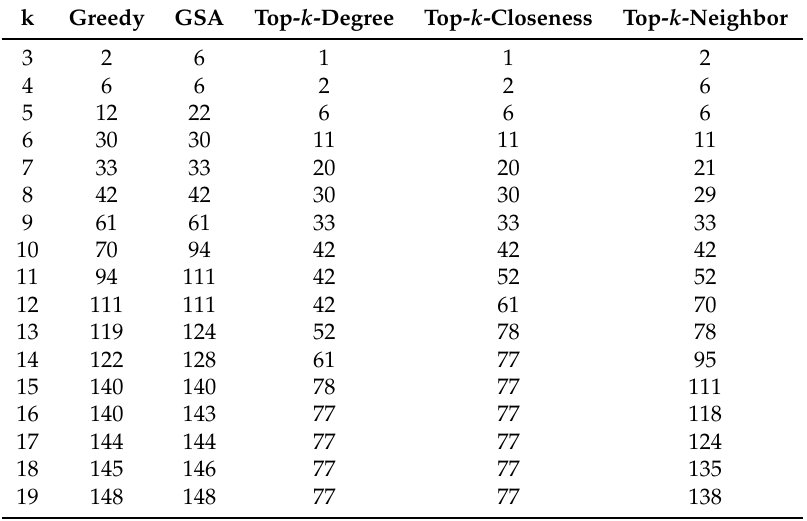
Table 9. The comparison of the approximate algorithm with the baseline algorithms: er-150.